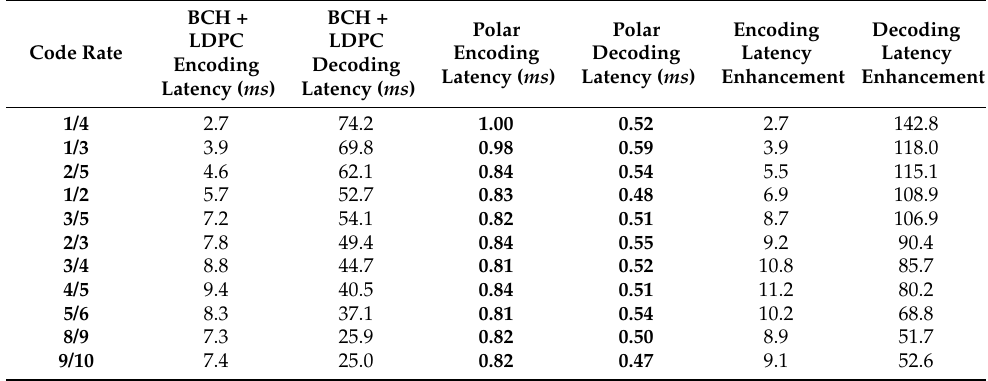
Table 6. Average latency comparisons between (LDPC+BCH) codes and optimized Polar code for normal frame at different code rates R . (bold cells represent the best values).